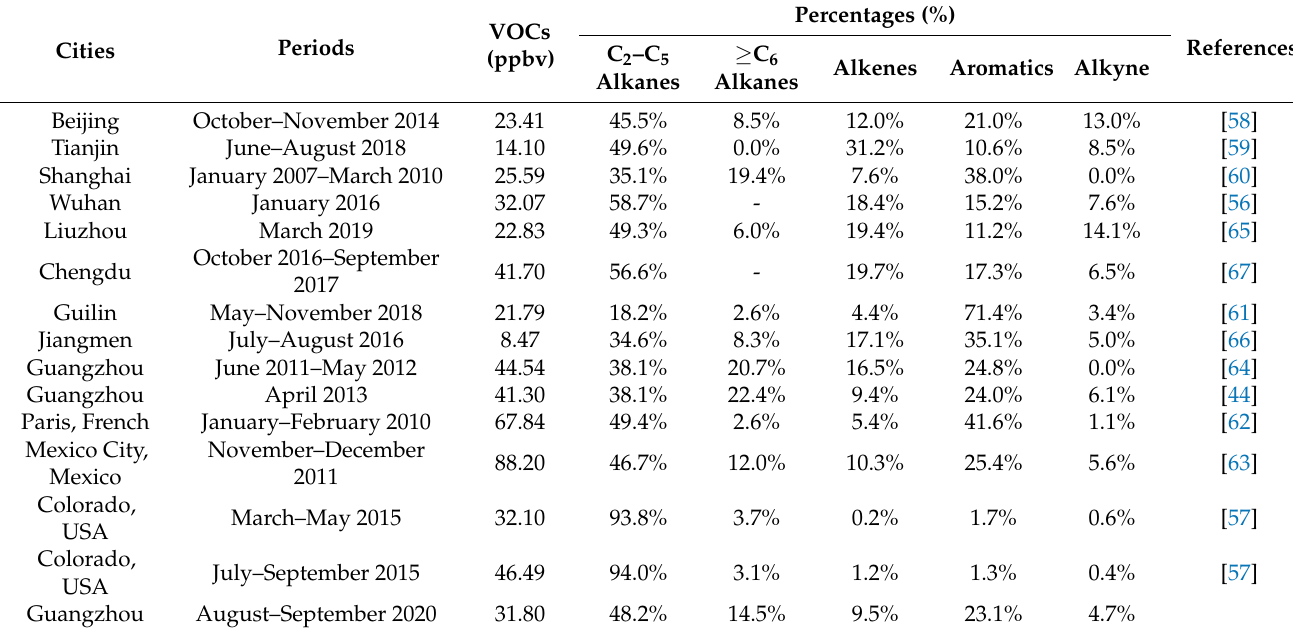
Table 1. Mixing ratio and composition of VOCs in Guangzhou and comparison of results with those of other